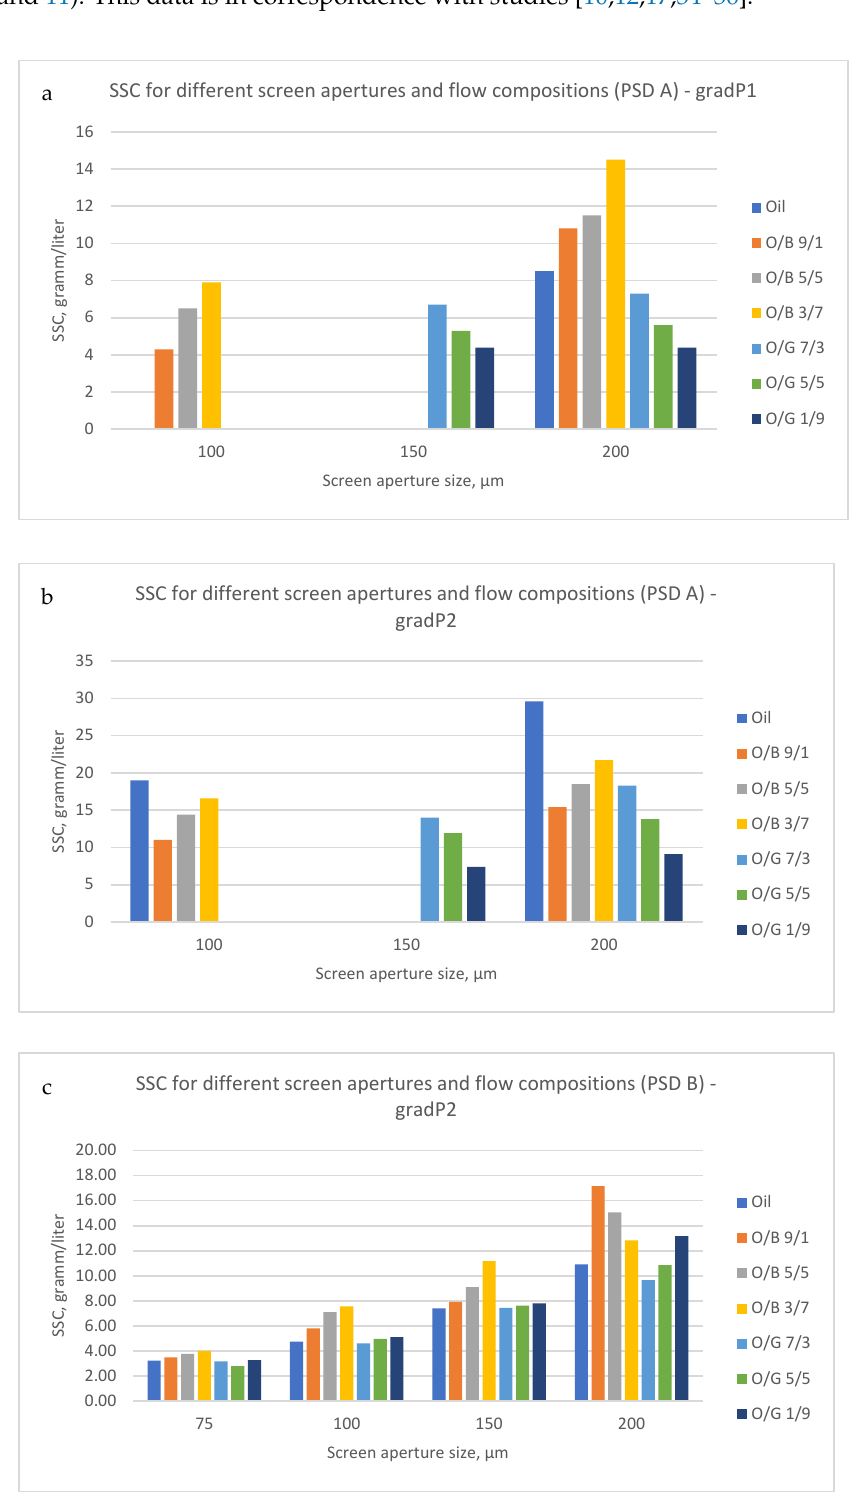
Figure 10. Suspended solids concentration for different particle size distributions, screen apertures, and flow compositions (( a )—PSD A gradP1, ( b )—PSD A gradP2 (4 times higher than gradP1), ( c )—PSD B gradP2).